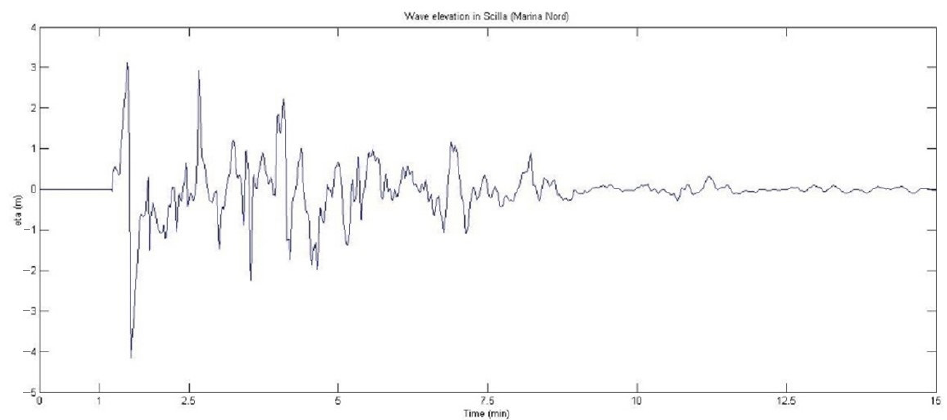
Figure 22. Free surface elevation obtained from the depth-integrated model in Monte Capo Pacì (the landslide source).